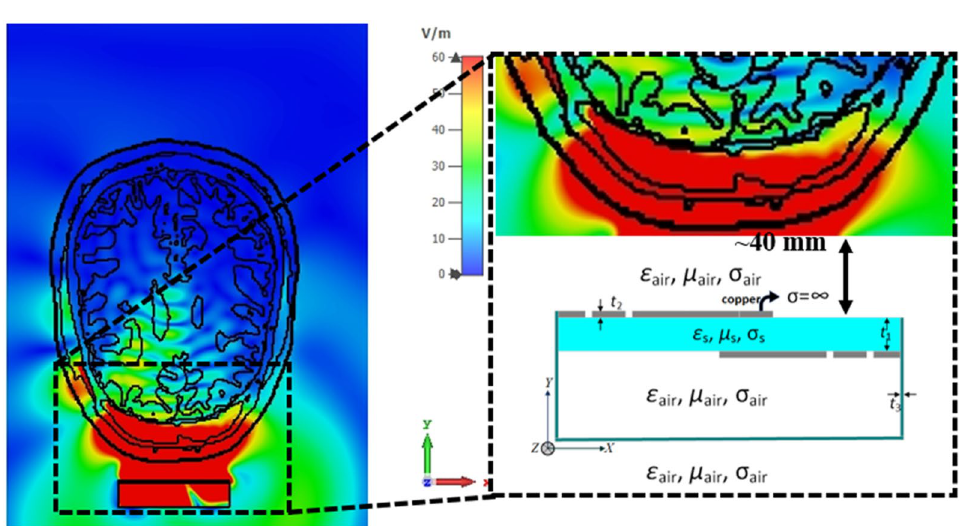
Figure 13. EMT perspective view for a phantom cross-section and the proposed antenna with relevant dielectric